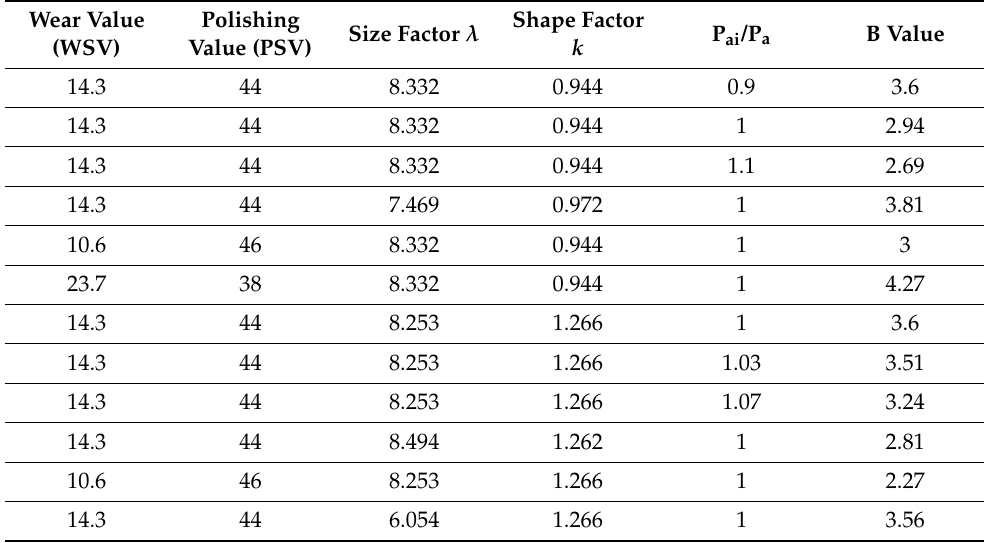
Table 8. Index values of various parameters of the asphalt mixture. Wear